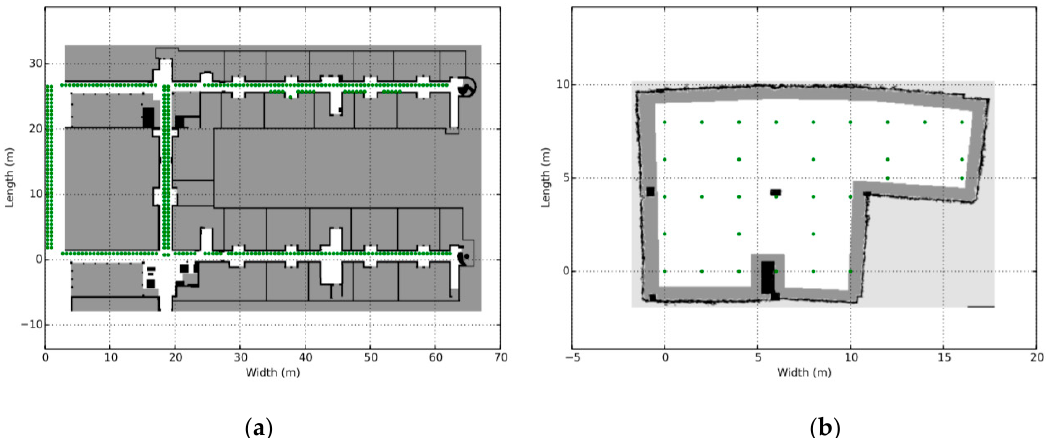
Figure 10. The construction of the location where the robots reside and the corridors where they can move [47] ( a ) Grenoble site, ( b ) Strasbourg